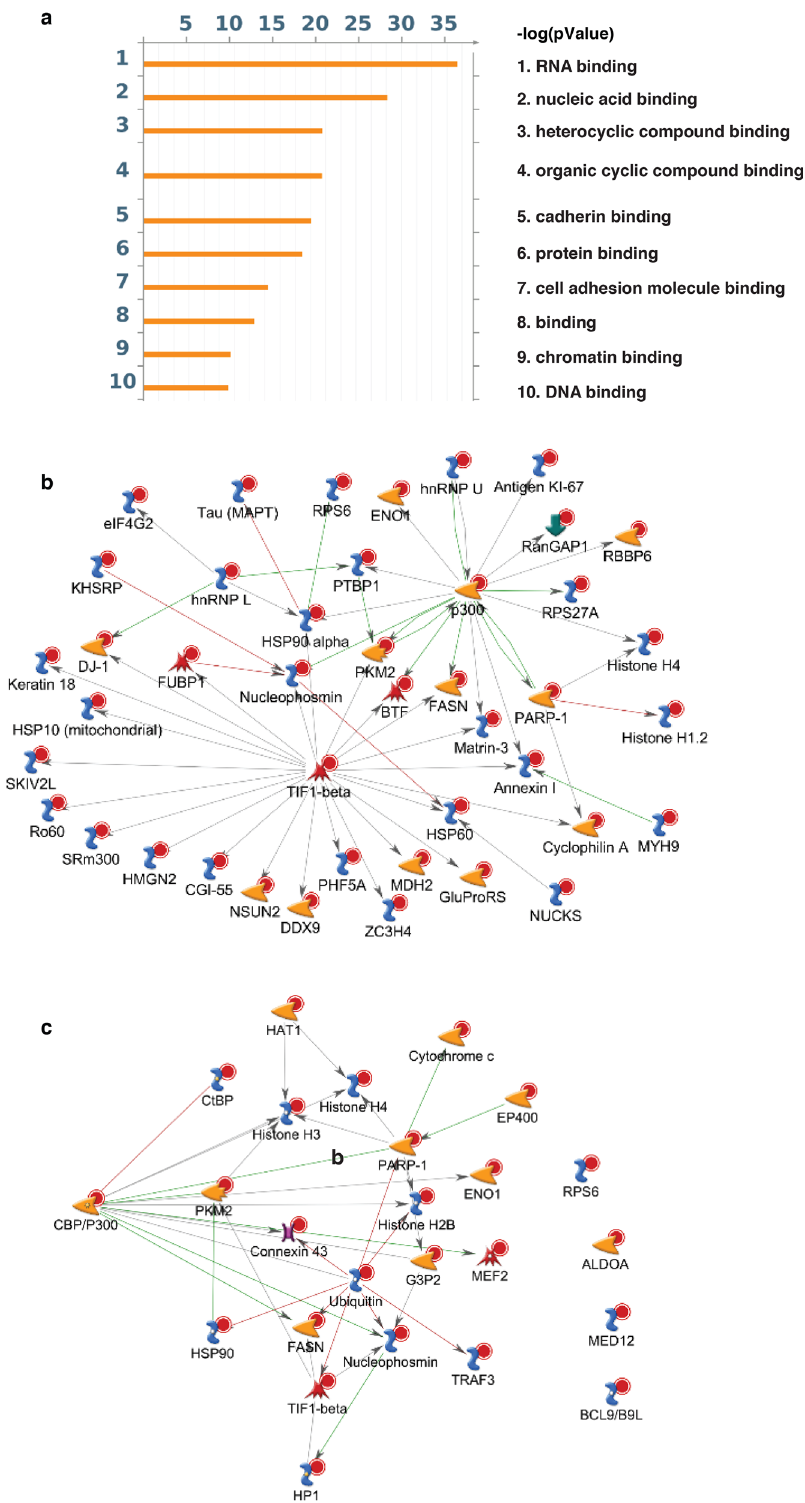
Figure 6. MetaCore molecular function enrichment analysis and interaction network. ( a ) MetaCore molecular function enrichment analysis of acetylated proteins both upregulated 1.5-fold following SIRT2 knockdown and downregulated 1.5-fold following SIRT2 overexpression. ( b , c ) Interaction network of acetylated proteins both upregulated 1.5-fold following SIRT2 knockdown and downregulated 1.5-fold following SIRT2 overexpression that function in RNA binding ( b ) and transcription regulation ( c